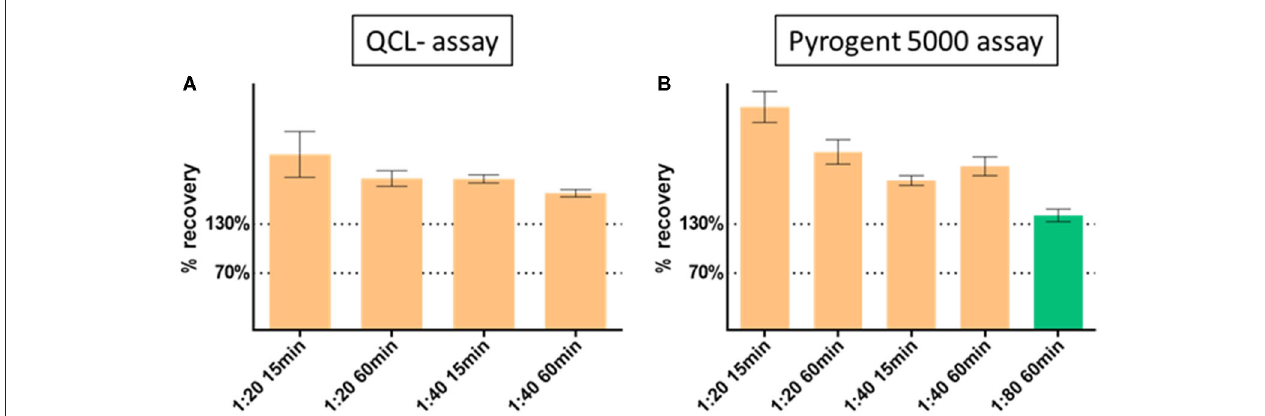
FIGURE 2 | Dilution linearity with (A) QCL and (B) Pyrogent 5000 kinetic assays. Spiked samples were serially diluted at 1:10 (reference at 100%), 1:20, 1:40 with endotoxin free water. The dilution 1:80 was further explored on the Pyrogent 5000 assay. Samples were heat treated on a heat block at 70 ◦ C for 15 or